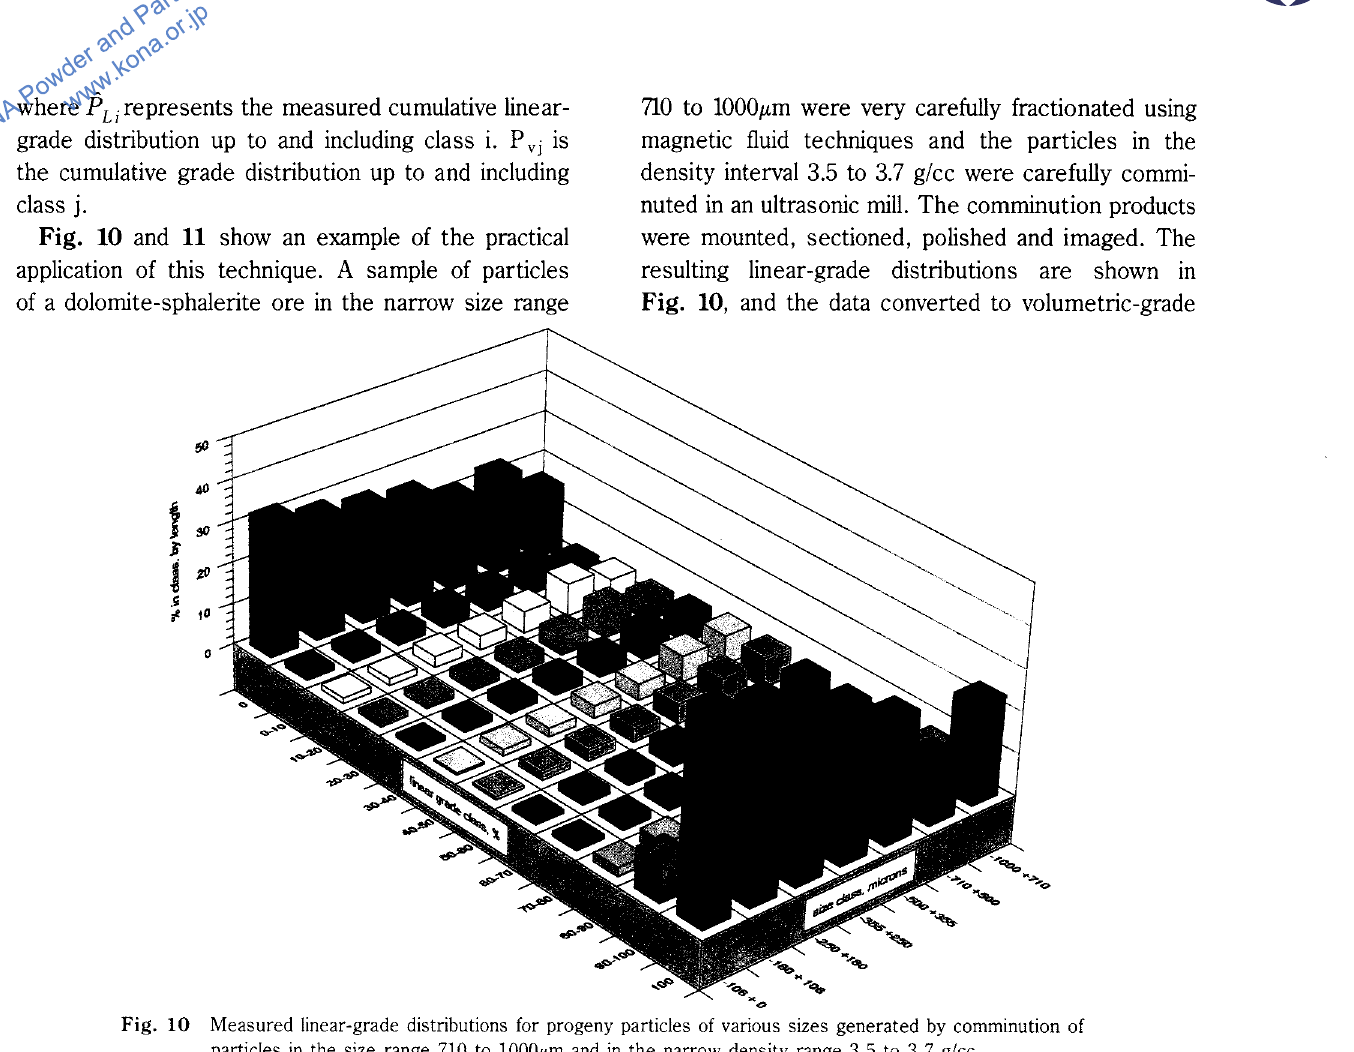
Fig. 10 Measured linear-grade distributions for progeny particles of various sizes generated by comminution of